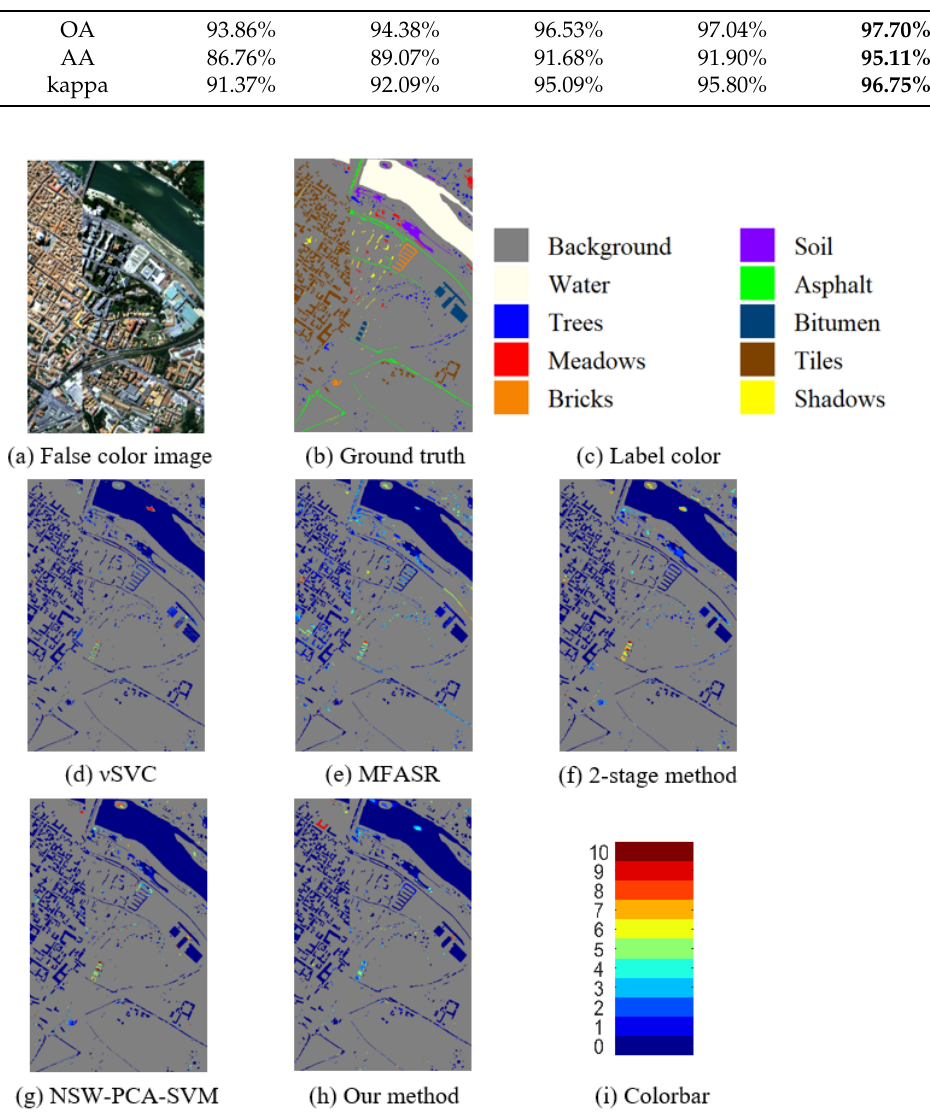
Figure 5. Results for the Pavia Center dataset. ( a ) The false color image. ( b , c ) The ground truth and corresponding label colors. ( d – h ) The misclassification counts of different methods. ( i ) The colorbar represents the misclassification